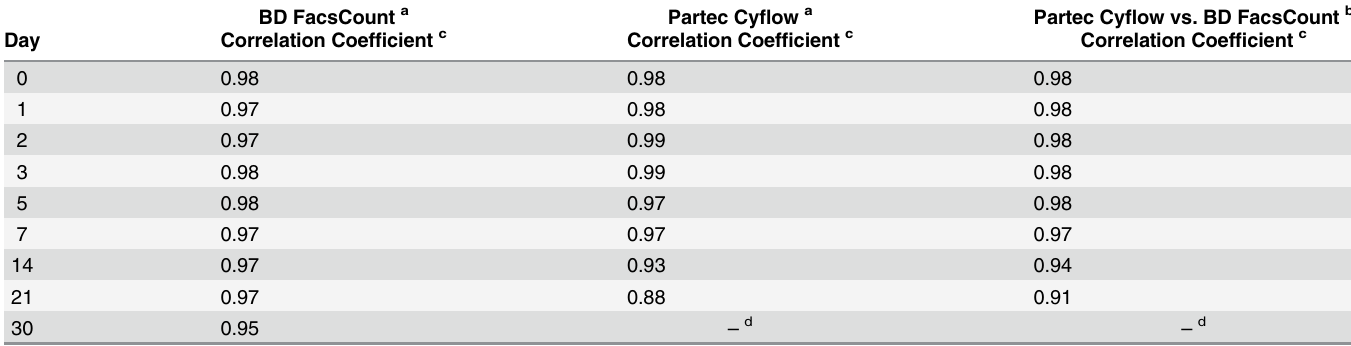
Table 3. Correlation of BD Vacutainer CD4 Stabilization Tube sample results on BD FacsCount and Partec Cyflow over time.